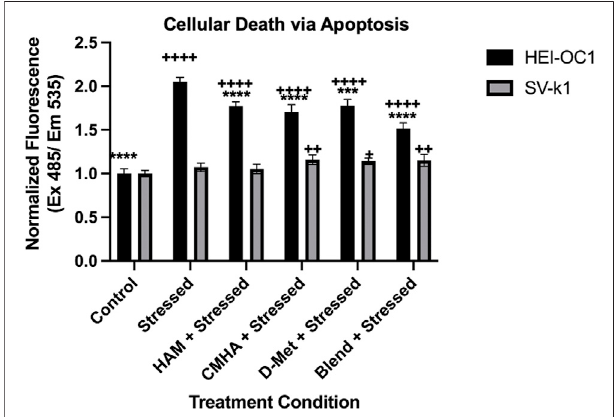
FIGURE 4 | HAM effects on cellular death/apoptosis in response to oxidative stress. Data presented are mean ± SD. One-way ANOVA with Tukey ’ s multiple comparisons run for each cell type individually. HEI-OC1 ANOVA results compared to stressed positive control: control p < 0.0001, HAM p < 0.0001, CMHA p < 0.0001, D-Met p = 0.0001, and blend p < 0.0001. **** p < 0.0001 and *** p < 0.001. HEI-OC1 ANOVA results compared to control cells: stressed p < 0.0001, HAM p < 0.0001, CMHA p < 0.0001, D-Met p < 0.0001, and blend p < 0.0001. Indicated with ++++ p < 0.0001. SV-k1 ANOVA compared to stressed positive control: control p = 0.3932, HAM p = 0.9952, CMHA p0.2071, D-Met p = 0.4274, and blend p = 0.2887. **** p < 0.0001. SV-k1 ANOVA results compared to control cells: stressed p = 0.3932, HAM p = 0.6887, CMHA = 0.0042, D-Met p = 0.0118, and blend p = 0.0065. Indicated with ++ p < 0.01 and ++ p <